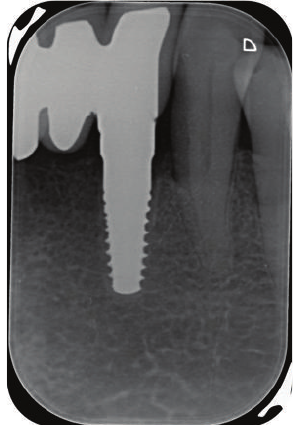
Figure 14: Radiographic control 4 years after implant